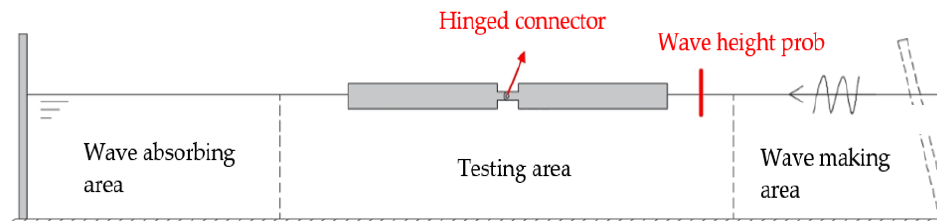
Figure 6. Relative position of the model and the tank equipment.